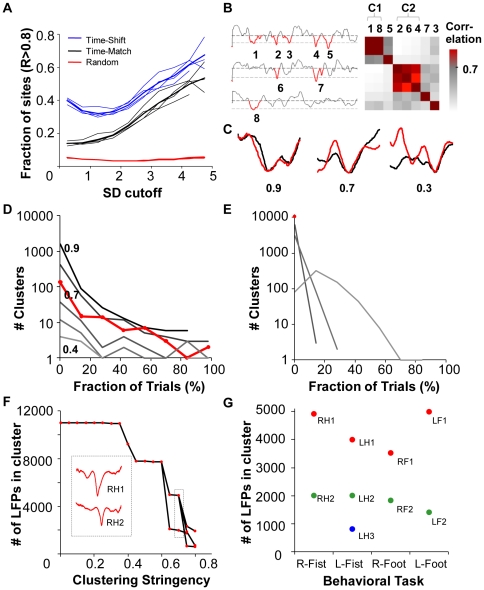
Trial Associated Coherence Potentials.(A) Fraction of sites with identical waveform (correlation R≥0.8) arising simultaneously (Time-Matched) or within ±10 ms milliseconds (Time-Shifted) increased non-linearly with increasing nLFP amplitude. Time-matched and time-shifted correlations calculated at 300 randomly selected sites per electrode could be fit to a sigmoidal function with an R2 of 0.99 and 0.95 respectively. (Light colors: values for each of the four behavioral tasks, dark lines: mean). Comparisons between randomly selected sites shown in red. (B) Large amplitude nLFPs (peak<-2SD from the mean; numbered 1–8 for 3 electrodes shown) were identified at all 59 electrodes across the entire recording spanning all 50 trials. Correlations between all pairs of identified nLFPs were calculated after aligning their peaks. The nLFPs were then grouped using a clustering algorithm based on their correlation values (8×8 correlation matrix shown here). (C) Three pairs of nLFPs with correlation values of 0.9, 0.7 and 0.5 show that increasing correlation reflects increasing similarity of temporal structure. (D) Cluster dispersion across trials for different correlation criteria for clustering in the right fist clenching task. At a low correlation criterion (light gray) all nLFPs collapse into a few clusters and thus span all trials (trial-spanning clusters). At higher correlation stringency, clusters splintered and only a few clusters persisted across all trials. R = 0.7 was chosen for further analysis. (E) Amplitude shuffled ECoG traces did not produce clusters that spanned all 50 trials. At high clustering stringencies (0.7) all clusters had only 1 nLFP demonstrating that these cascading nLFPs are a non-random phenomenon. (F) Splintering of trial-spanning clusters with increasing correlation criteria for clustering (right fist clenching task shown here, other tasks shown in Figure S1). The lines connect the parent cluster from which smaller clusters have separated. Only trial-spanning clusters are shown in the figure. Two clusters persist across all trials even for high correlation criterion. Inset: Mean traces of the nLFPs in the two clusters at R = 0.7 are shown in the same order. (G) Cluster sizes (number of nLFPs) of the nine trial-spanning clusters from all four behavioral tasks. (Colors and the cluster names shown are used in subsequent figures).